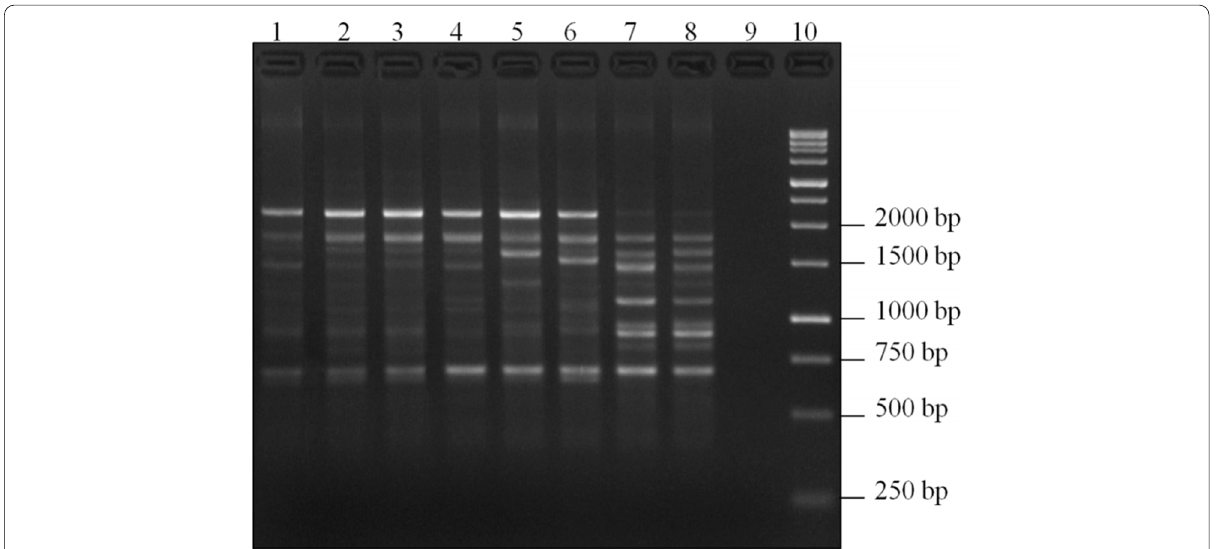
Fig. 1 Electropherogram of PCR products of ryegrass samples with SCoT-06 marker. Perennial ryegrass cultivars: Agat (1), Duet (2), VIK 66 (3), Karat (4), Fenix (5), VIK 22 (6); annual ryegrass: Rapid (7), Moskovsky 74 (8); 9 – control (H 2 O); 10 – molecular weight marker (1kb DNA Ladder, Evrogen, Russia)